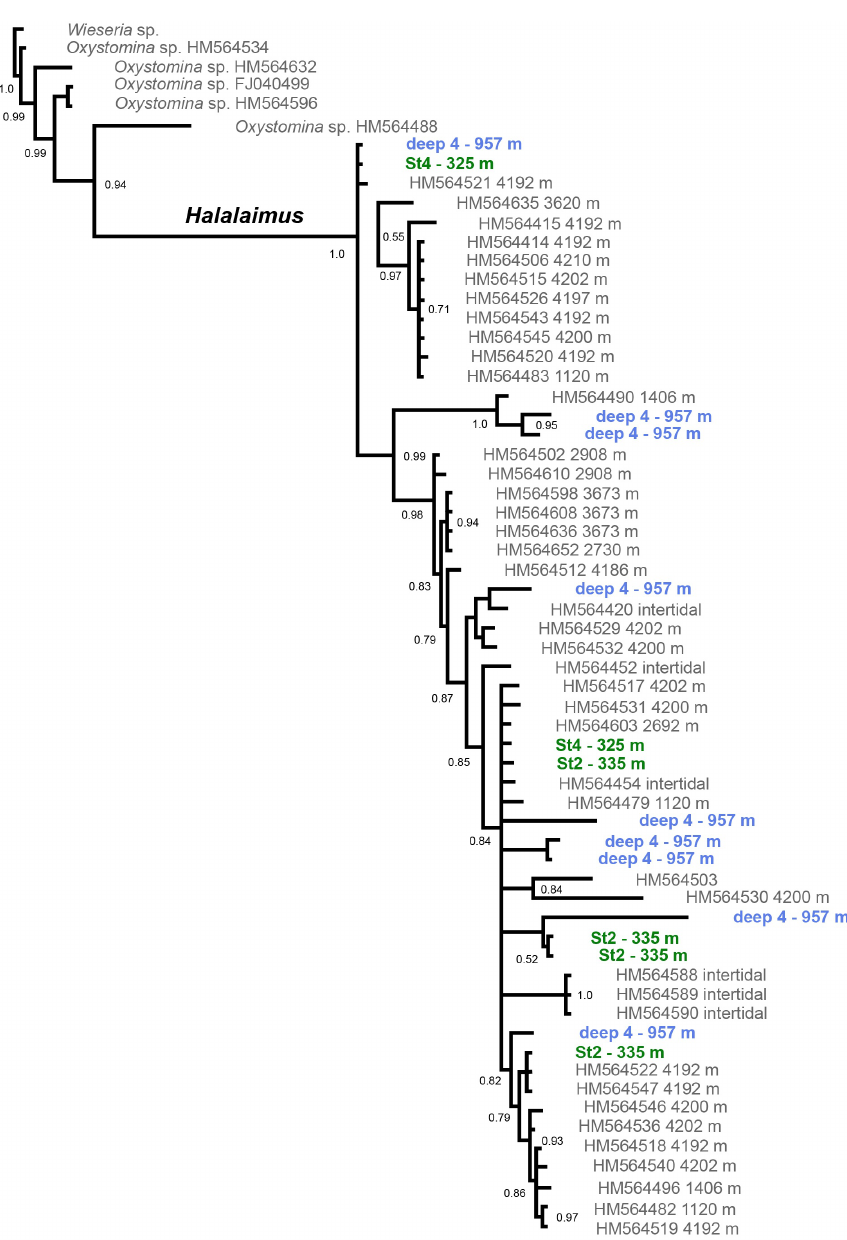
Figure 8. Consensus of Bayesian inference of phylogeny of the genus Halalaimus based on 18S rDNA sequence fragments generated in this study and from Bik et al. (2010); node support is given as posterior probabilities (PP) and nodes with PP smaller than 0.50 were collapsed. The outgroup was set to Wieseria . The tree shows multiple instances of close relationships between individuals collected at different depth